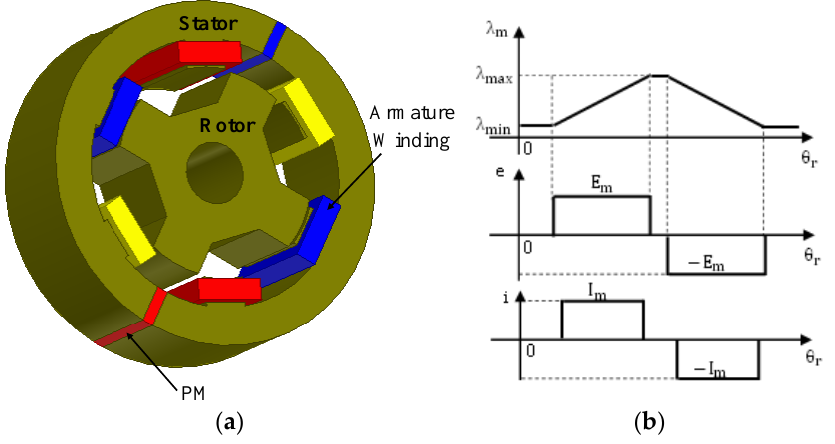
Figure 2. Classification of brushless stator mounted machines.